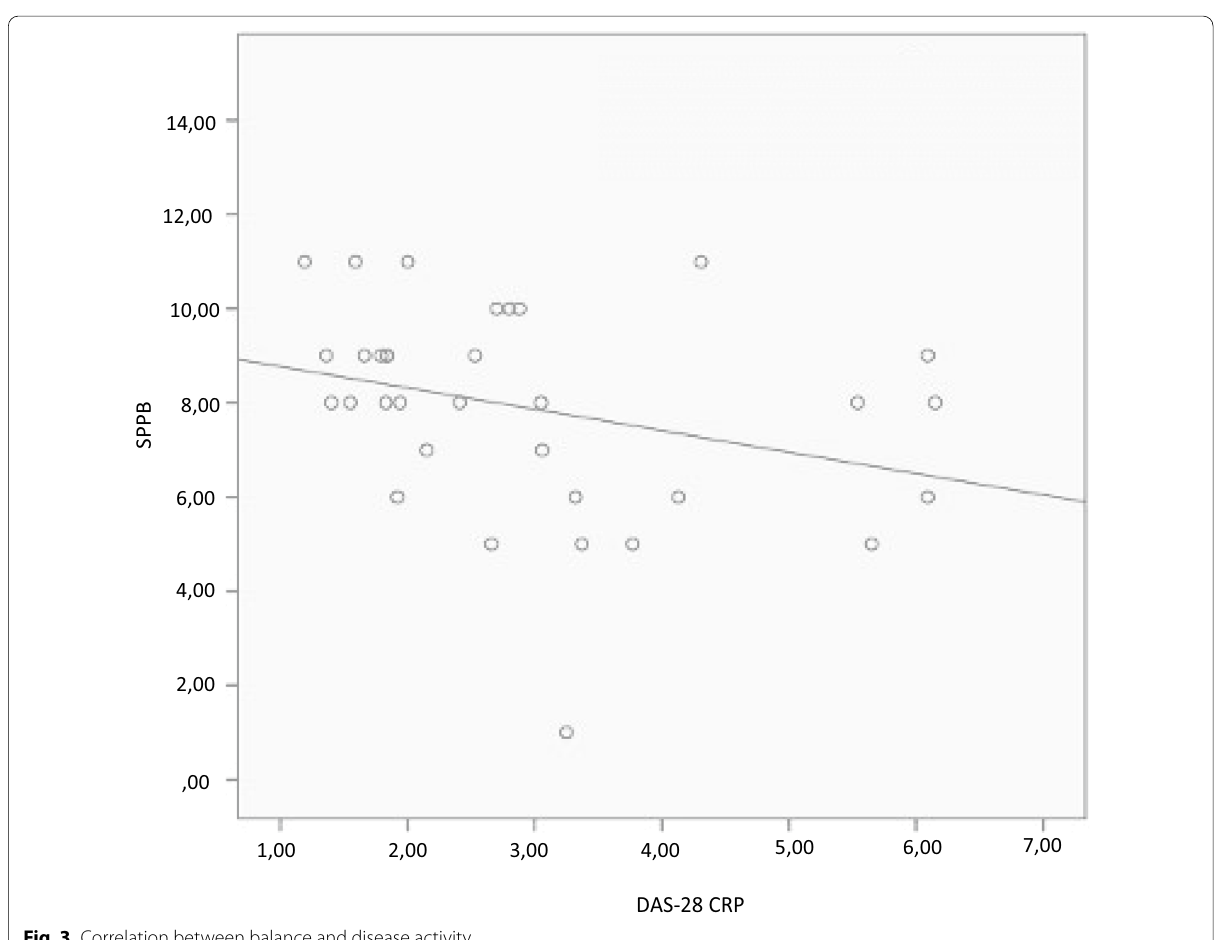
Fig. 3 Correlation between balance and disease